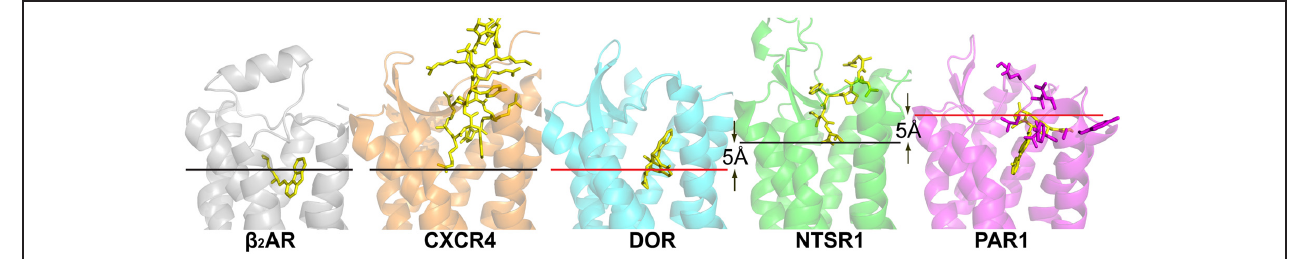
FIGURE 1 | Crystal structures of peptide receptors. Receptors were aligned in PyMol. Ligands are shown as yellow sticks, receptors are shown as cartoons. CXCR4 with the cyclic peptide antagonist CVX15 (PDB code 3OE0), DOR with the morphinan antagonist naltrindole (PDB code 4EJ4), NTSR1 with the peptide agonist NTS 8 − 13 (PDB code 4GRV), and PAR1 with the antagonist vorapaxar (PDB code 3VW7). For